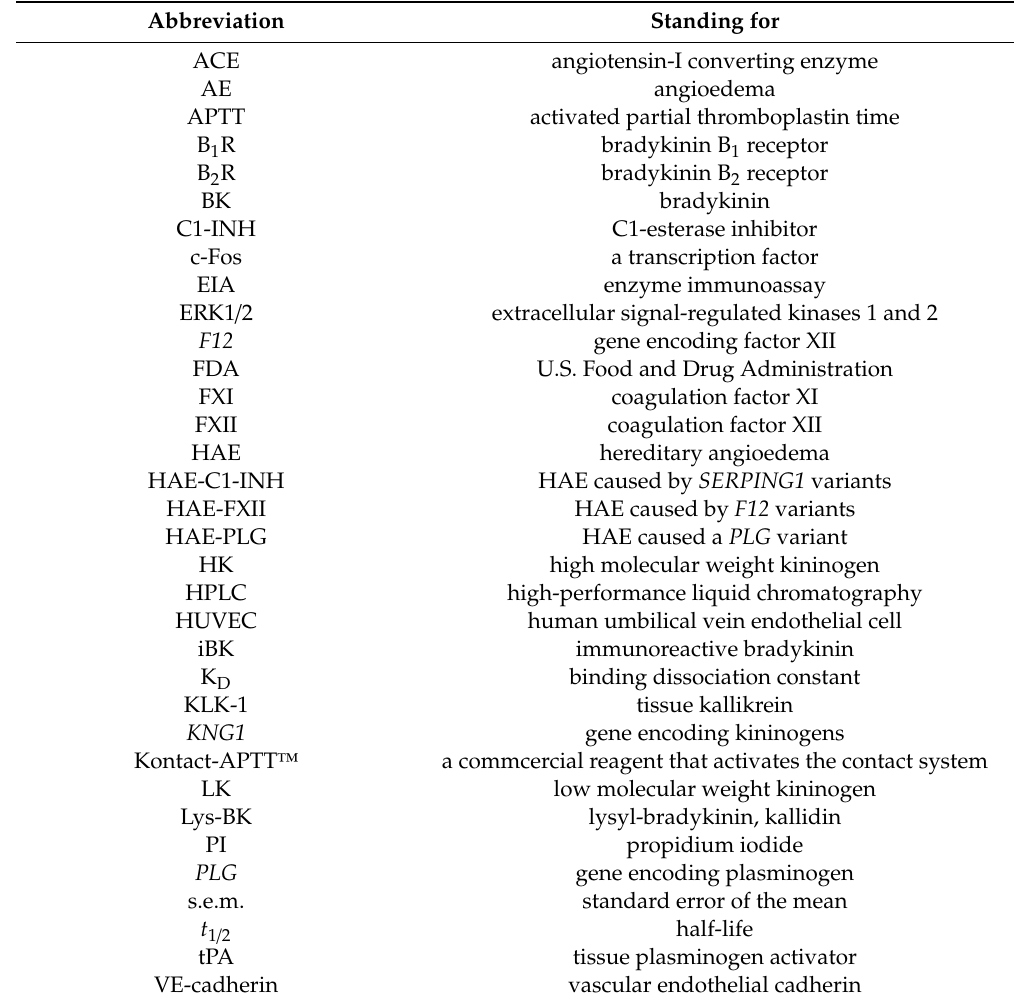
Table 1. List of